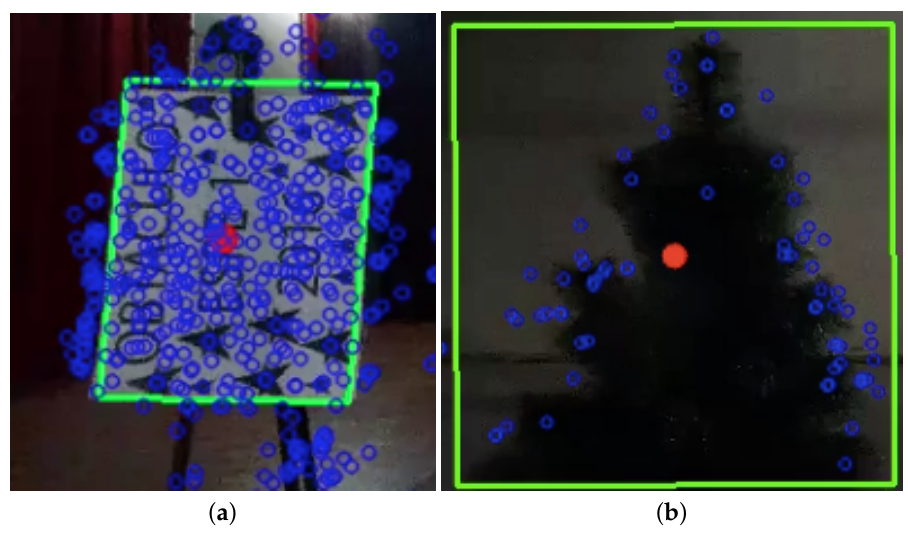
Figure 6. Area and mass center of obstacle. ( a ) Pre-designed obstacle; ( b ) obstacle present in the